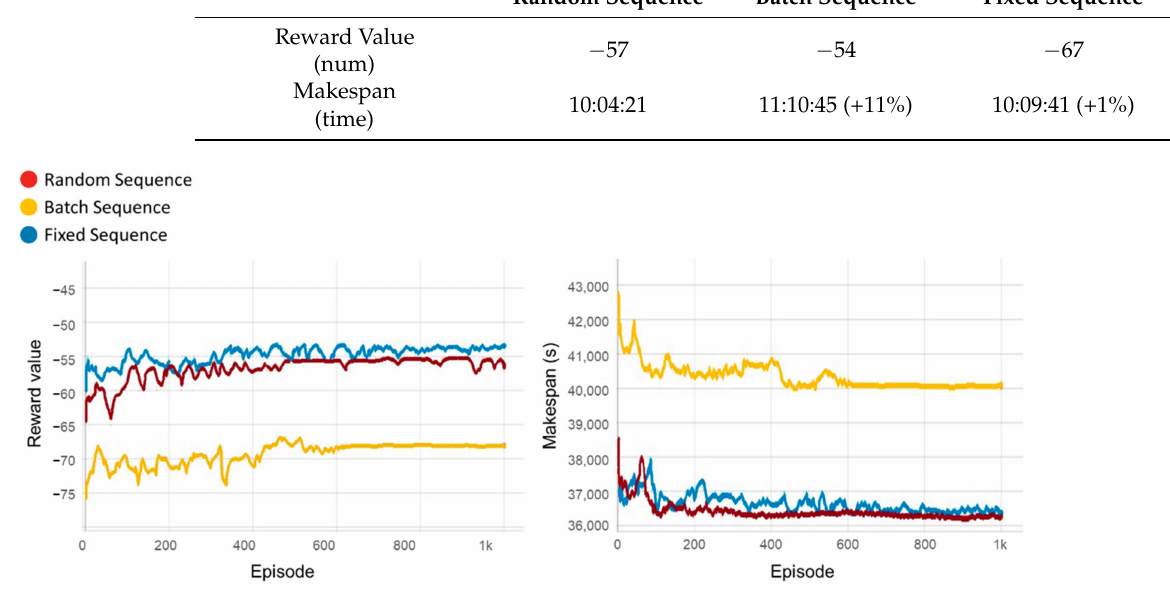
Figure 11. Reward value and makespan comparison by